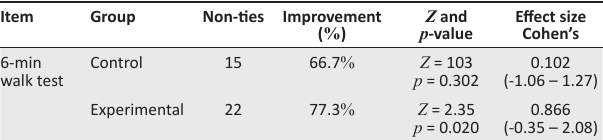
IQR, interquartile TABLE 8: Within-group changes for 6-min walk test. Item Group